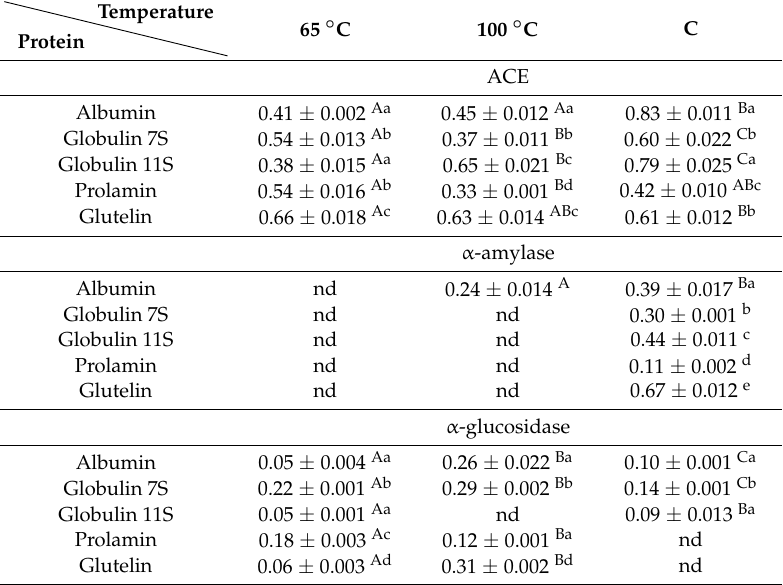
Table 3. The IC 50 (mg/mL) values of peptide fractions on activity of enzymes involved in metabolic syndrome